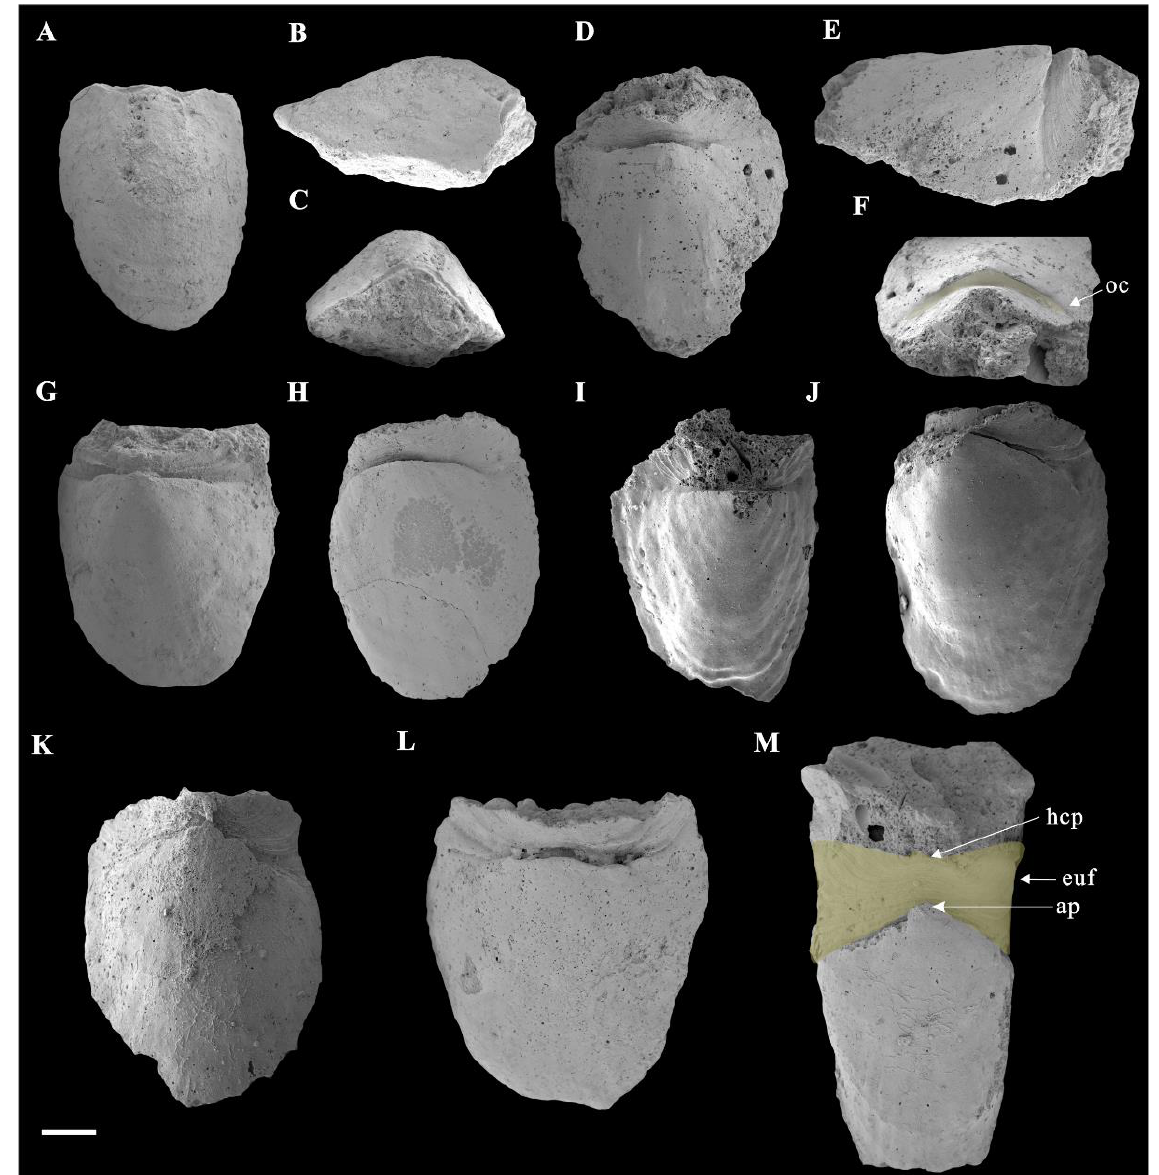
Figure 2. Eohalobia sclerites, from Member 5 of the Yanjiahe Formation in Yanjiahe section ( Wat- sonella crosbyi Assemblage Zone). ( A – C , D – F ) Internal molds, CUBar228 – 2, CUBar228 – 5, respec- tively. ( G – M ) Internal molds, CUBar110 – 7, CUBar212 – 1, CUBar101 – 1, CUBar101 – 2, CUBar40 – 1, CUBar212 – 3, CUBar212 – 2, respectively. ( A , D , G – M ) Dorsal view. ( B , E ) Lateral view. ( C , F ) Proximal view. Colored areas show oblique cavity and butterfly-shaped extended field. Scale bar equals 500 μm. Abbreviations: ap = apex of shell; euf = the extended and upfolded field; hcp = high -arched central part; oc = oblique cavity.